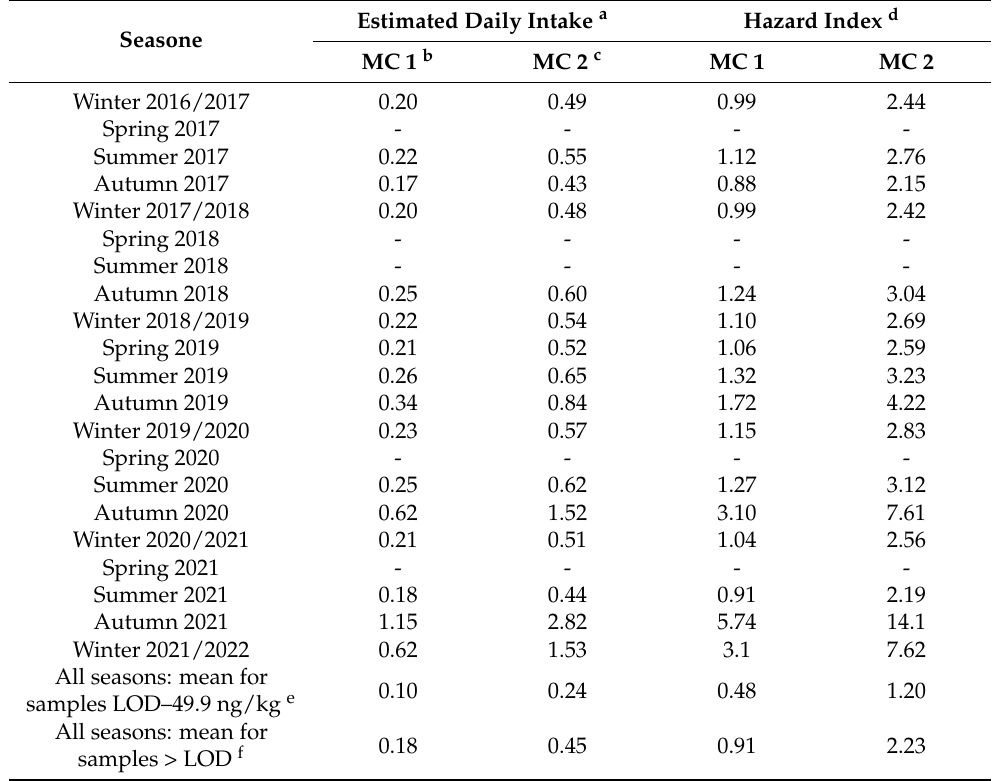
Table 4. Estimated daily intake (EDI) and Hazard Index (HI) for AFM 1 -positive samples for Croatian adults via consumption of raw milk during seasons